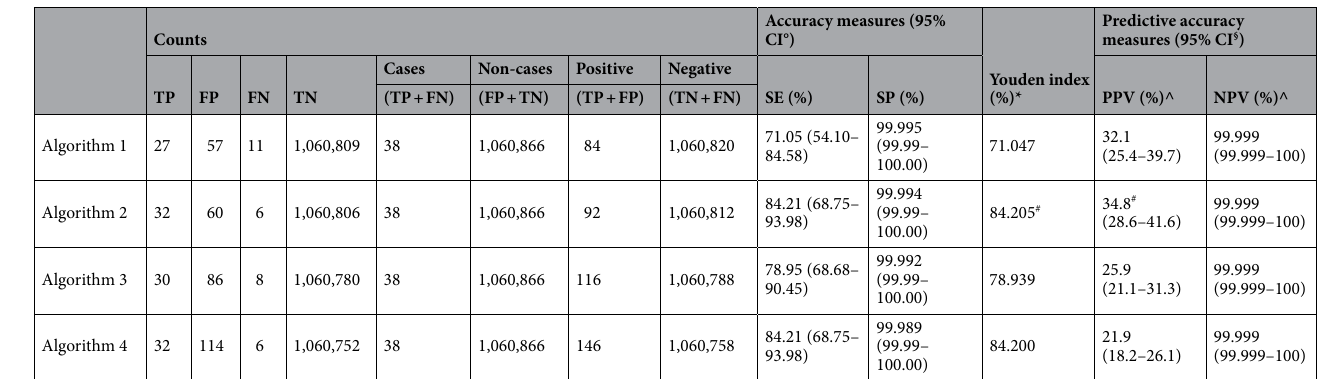
Table 3. Number of subjects with at least one diagnosis code for acromegaly in the electronic therapeutic plans databases from Caserta Local Health Unit (cases) and other subjects registered in Caserta Local Health Unit (non-cases) in the period January 2015–December 2018, as well as number of true and false positive/ negative counts, diagnostic and predictive accuracy measures with respect to each proposed algorithm. ^PPV and NPV were computed taking into account that the disease prevalence in Caserta Local Health Unit was 3.61 cases per 100,000 persons (i.e. 38 true cases over a total sample of 1,051,943 subjects); °CI calculated using the exact Clopper–Pearson method for a binomial proportion; § CI calculated using the standard logit confidence intervals. Predictive measures are dependent on disease prevalence; *The Youden Index is computed as the sum of SE (%) and SP (%) minus 100% and denote the accuracy of each considered algorithm; # The algorithm with the highest accuracy. TP True Positive, FP False Positive, FN False Negative, TN True Negative, SE sensitivity, SP specificity, PPV Positive Predictive Value, NPV Negative Predictive Value, CI confidence